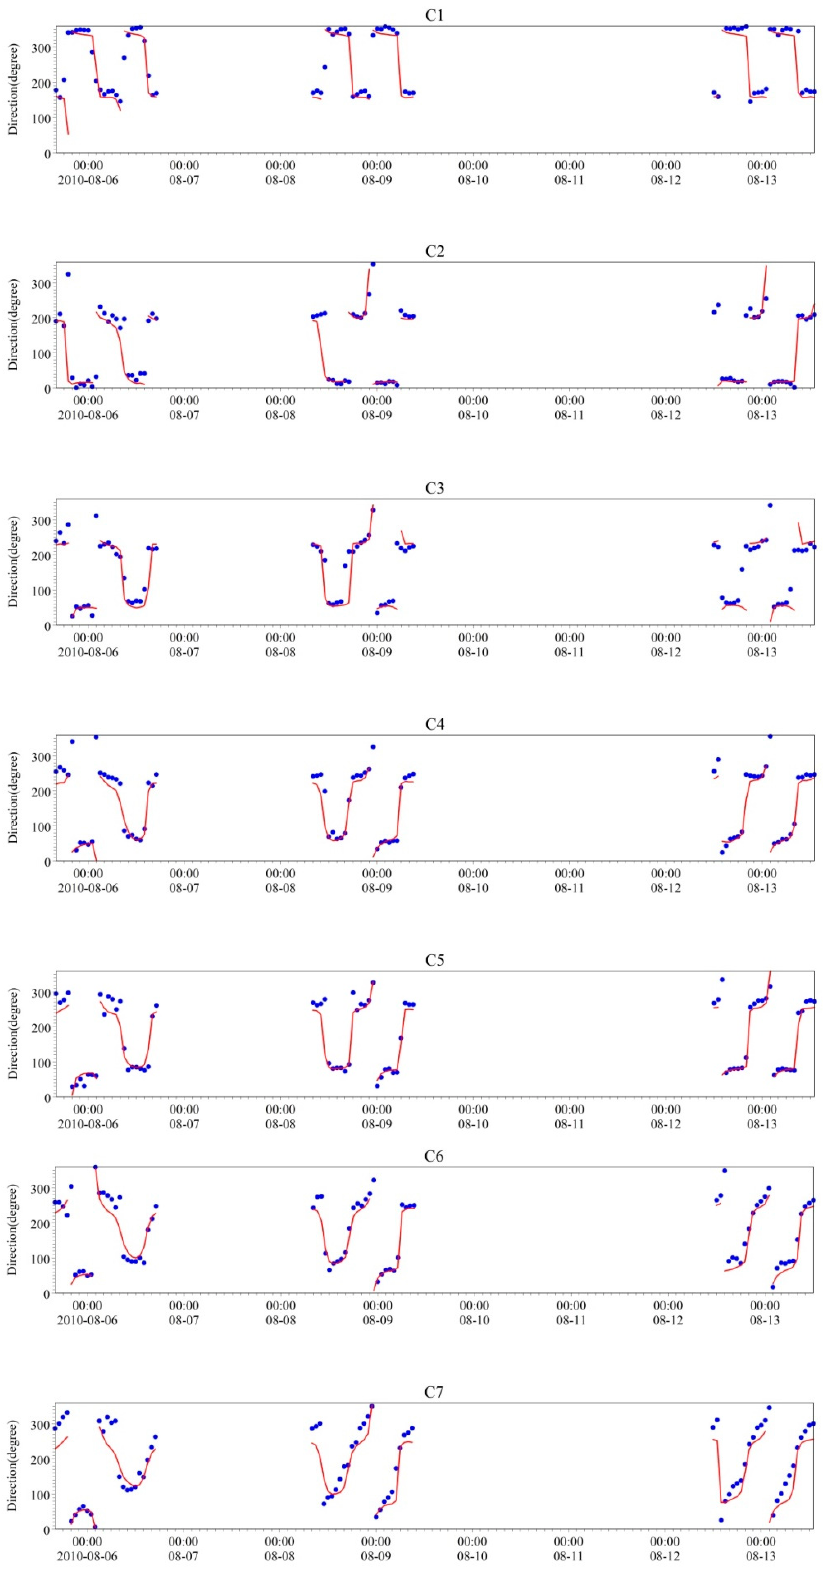
Figure 6. Tidal current direction validation results ( signify the measured values; signify the simulated values).